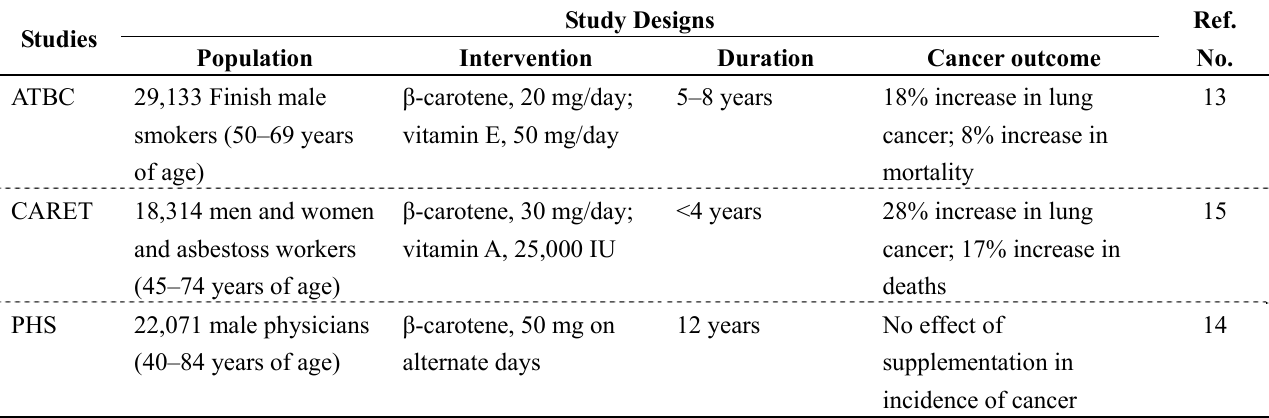
Table 2. β -Carotene supplementation